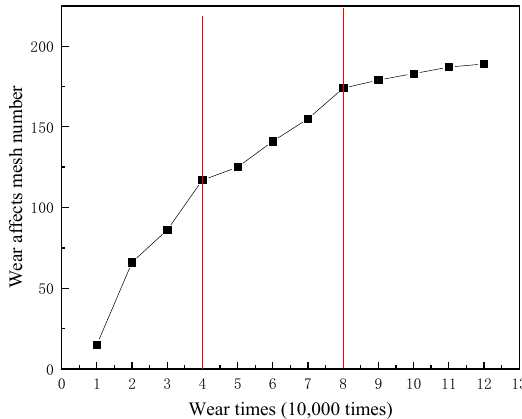
Figure 15. Change of wear area with wear times.